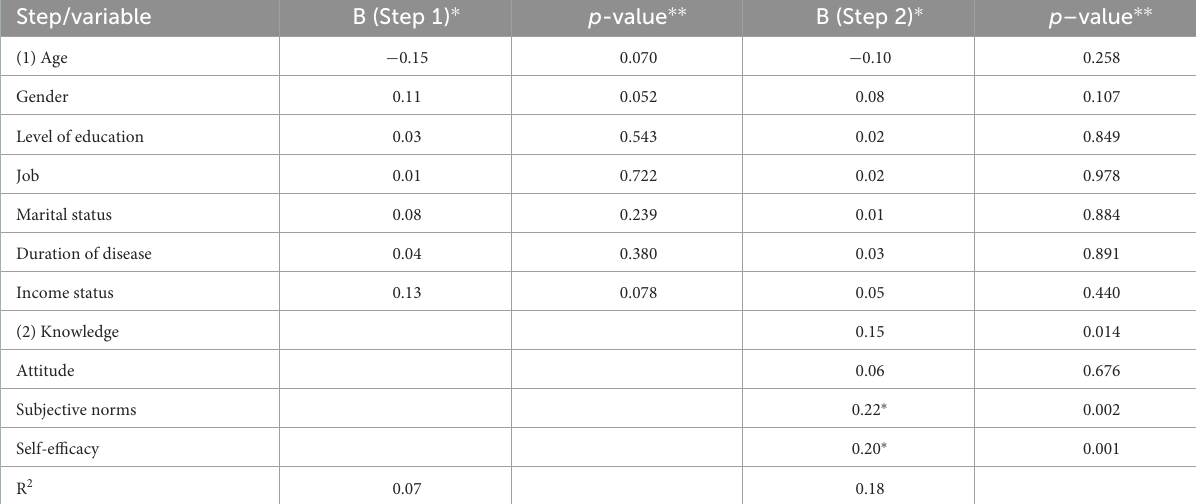
TABLE 3 Hierarchical regression analysis to predict the behavioral intention among diabetic patients.